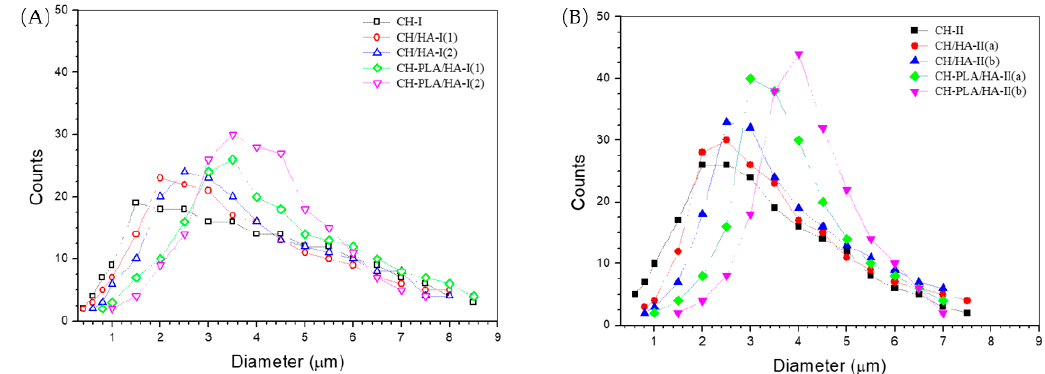
Figure 3. Variations in size-distribution of microspheres in set-one ( A ) and in set-two ( B ) (see Table 2 for their compositions).